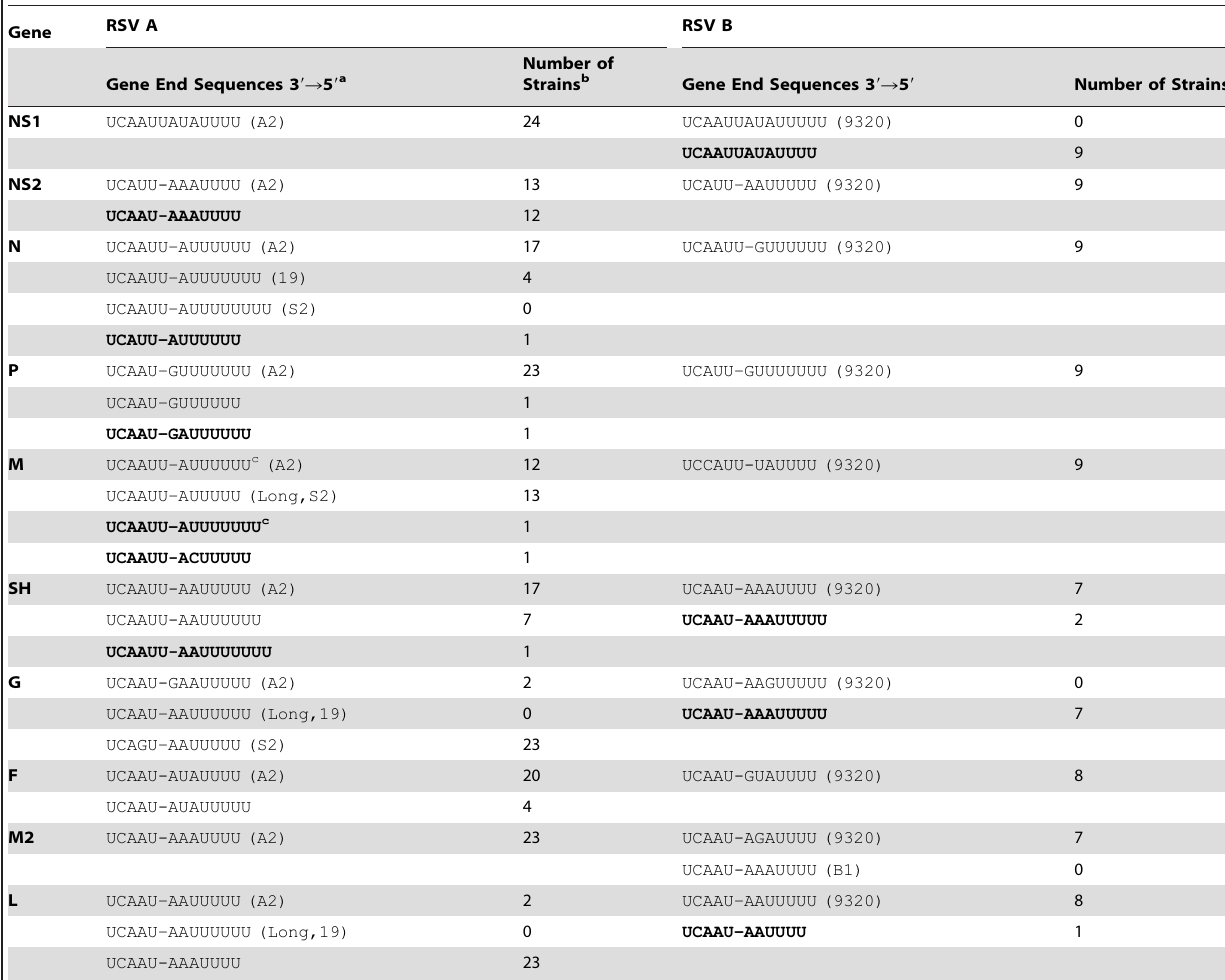
Table 5. The gene end sequences of RSV A and